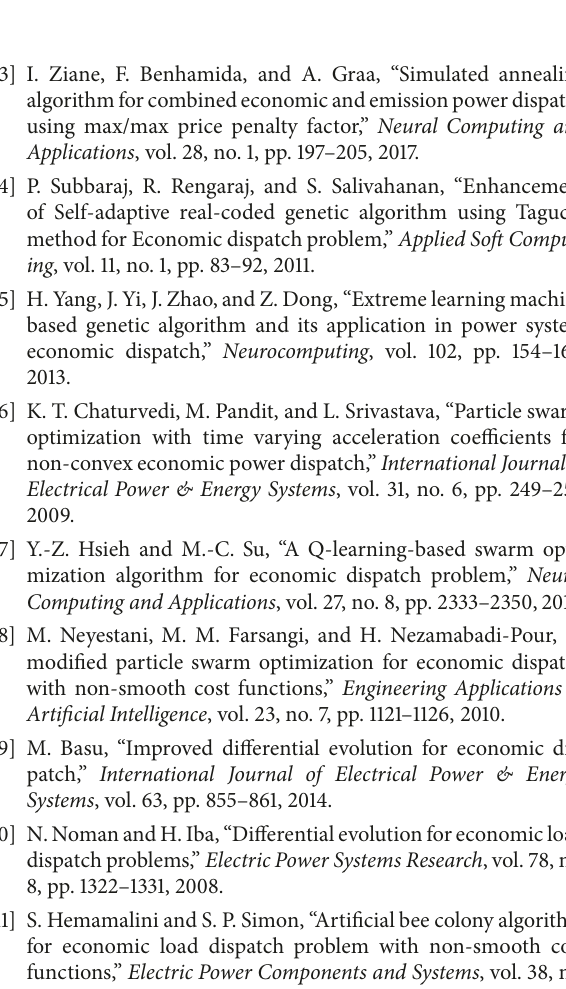
Figure 9: Operation performance of all